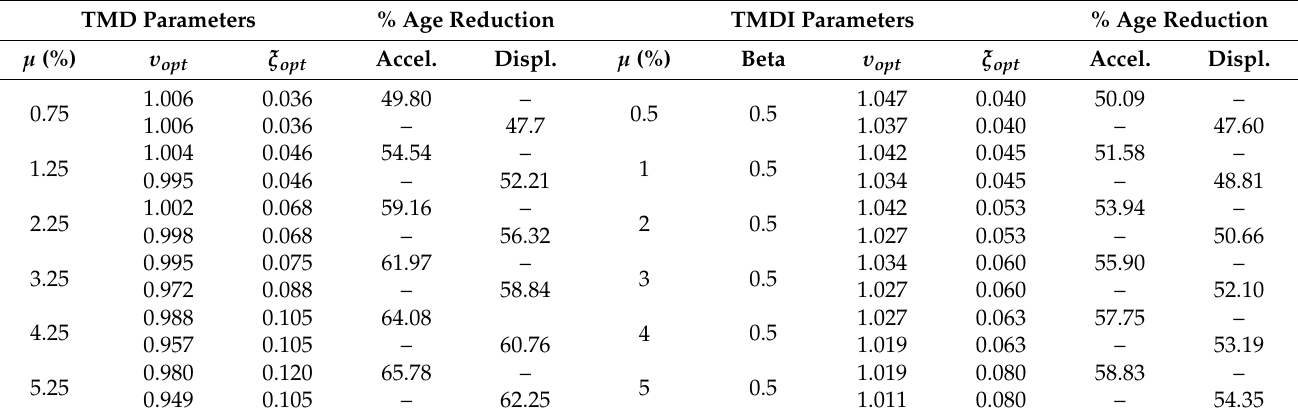
Table 4. Optimal parameters of TMDI and equivalent TMD for the different mass